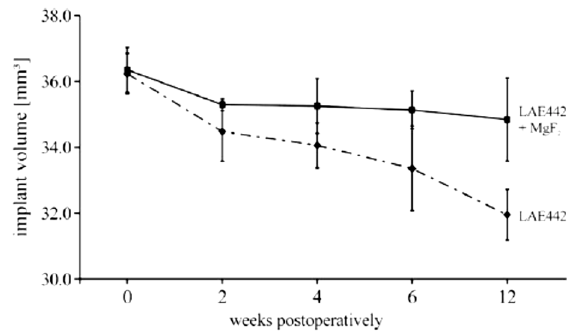
Figure 36. Implant volume of LAE442 and MgF 2 -coated LAE442 at different postoperative intervals. Reproduced with permission from [172], Elsevier, 2010.